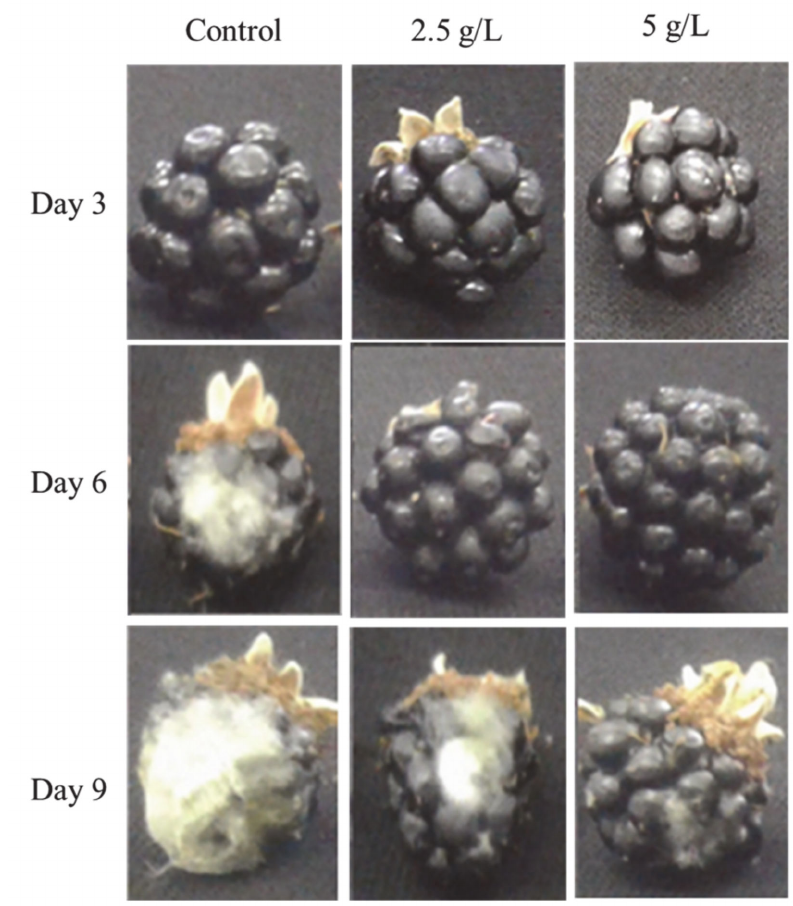
Figure 1. Effect of chitosan nanoemulsion on the shelf life of